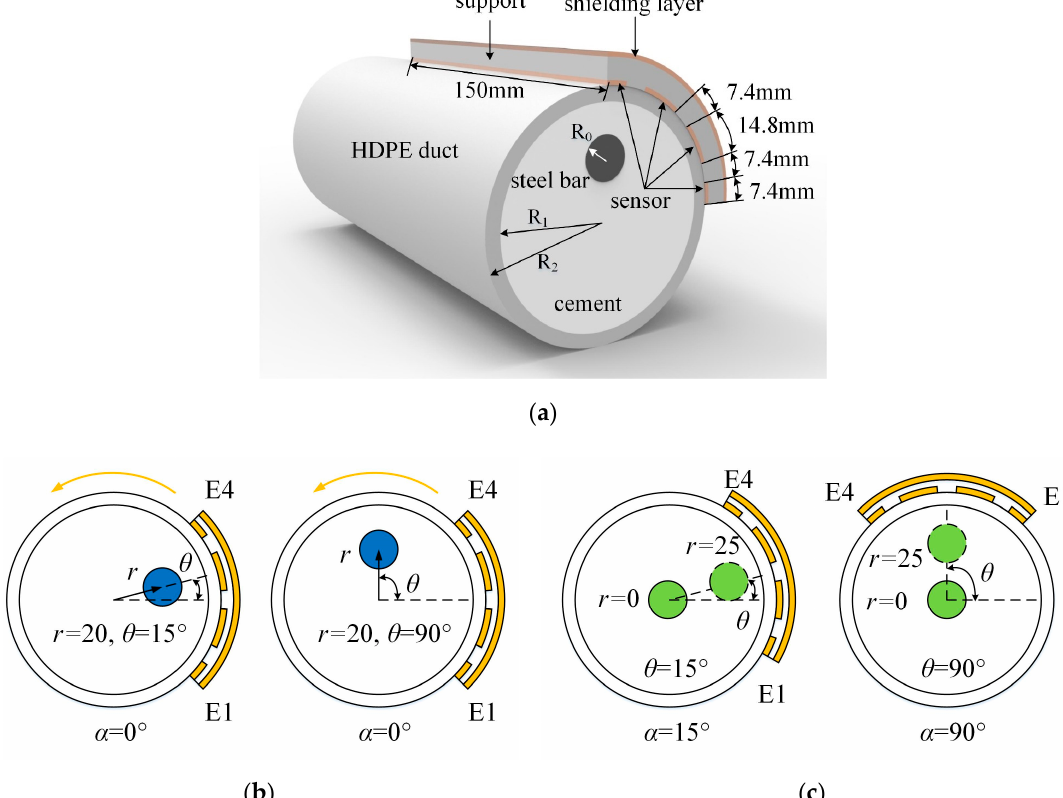
Figure 5. The phantoms for the simulations and experiments. ( a ) Schematic diagram of simulations and experiments; ( b ) the phantoms for θ detection in the first-round measurements; ( c ) the phantoms for r detection in the second-round